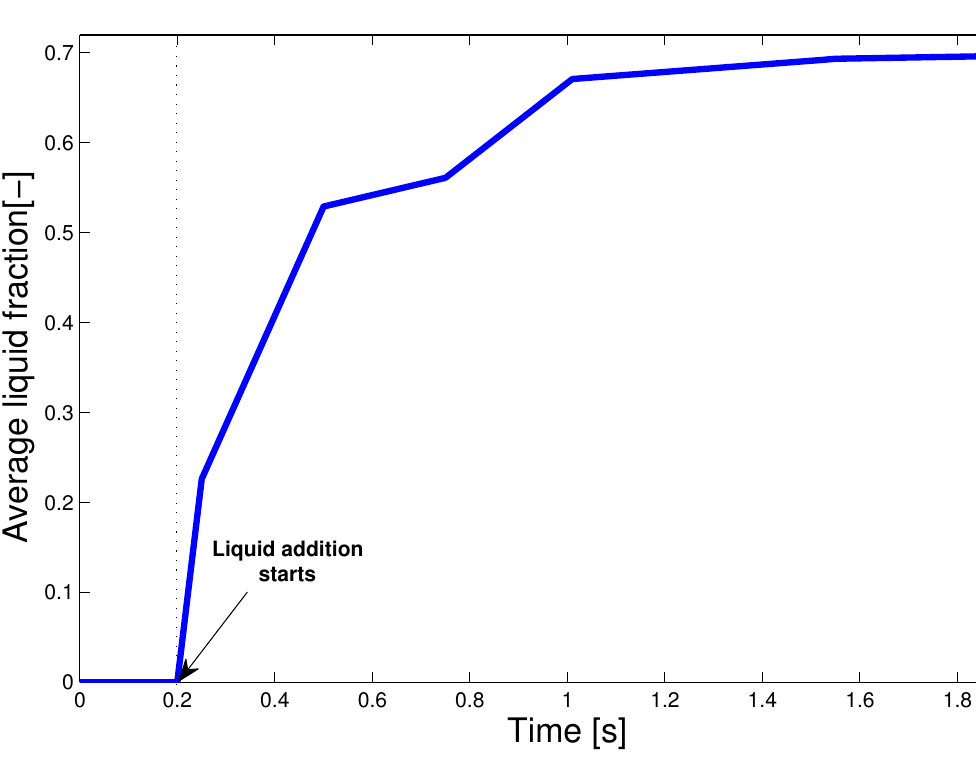
Figure 6. Liquid content vs.